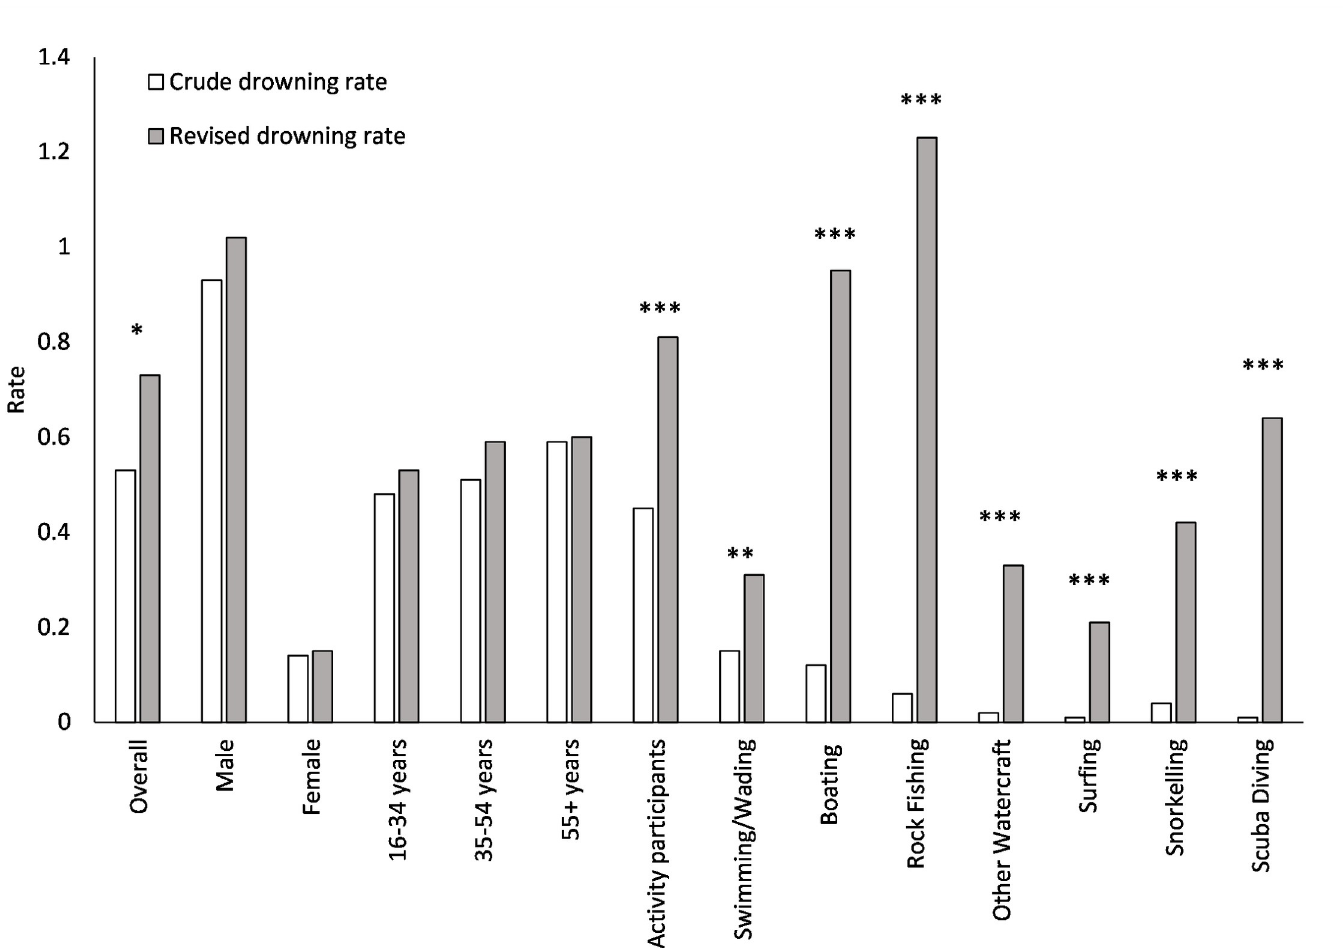
Fig 4. Crude drowning rate per 100,000 population compared with the revised drowning rate per 100,000 participants calculated using participation data collected by the National coastal safety survey. Levels of significant differences between the rates are illustrated with asterisks: p < 0.02 ( � ), p < 0.001 ( �� ), p � 0.0001( ��� ), and highlight target groups for which this methodology is